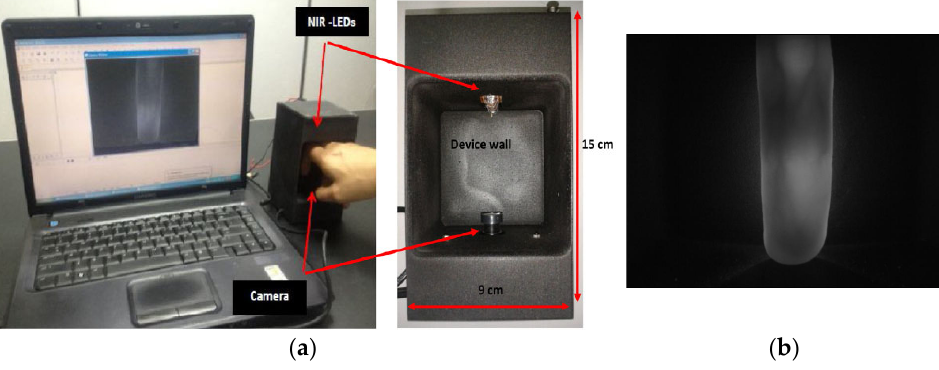
Figure 8. FV-USM dataset [18]: ( a ) Vein imaging device; ( b ) Example of a vein image. Anyway, the SDU-MLA dataset is created by Shandong University. It contains 636 vein images from 106 subjects. Six images each of every subject’s left and right index, middle, and ring fingers are contained in the dataset. The light sources in the testing environment are unstable and finger positioning is unstable, so the resolution is 320 × 240, as shown in Figure 9.